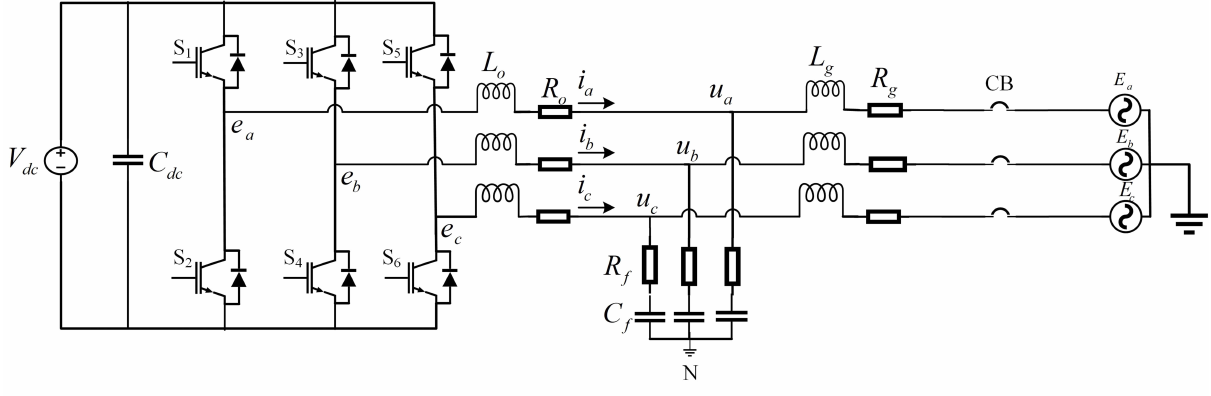
Figure 1. Power part of the inverter